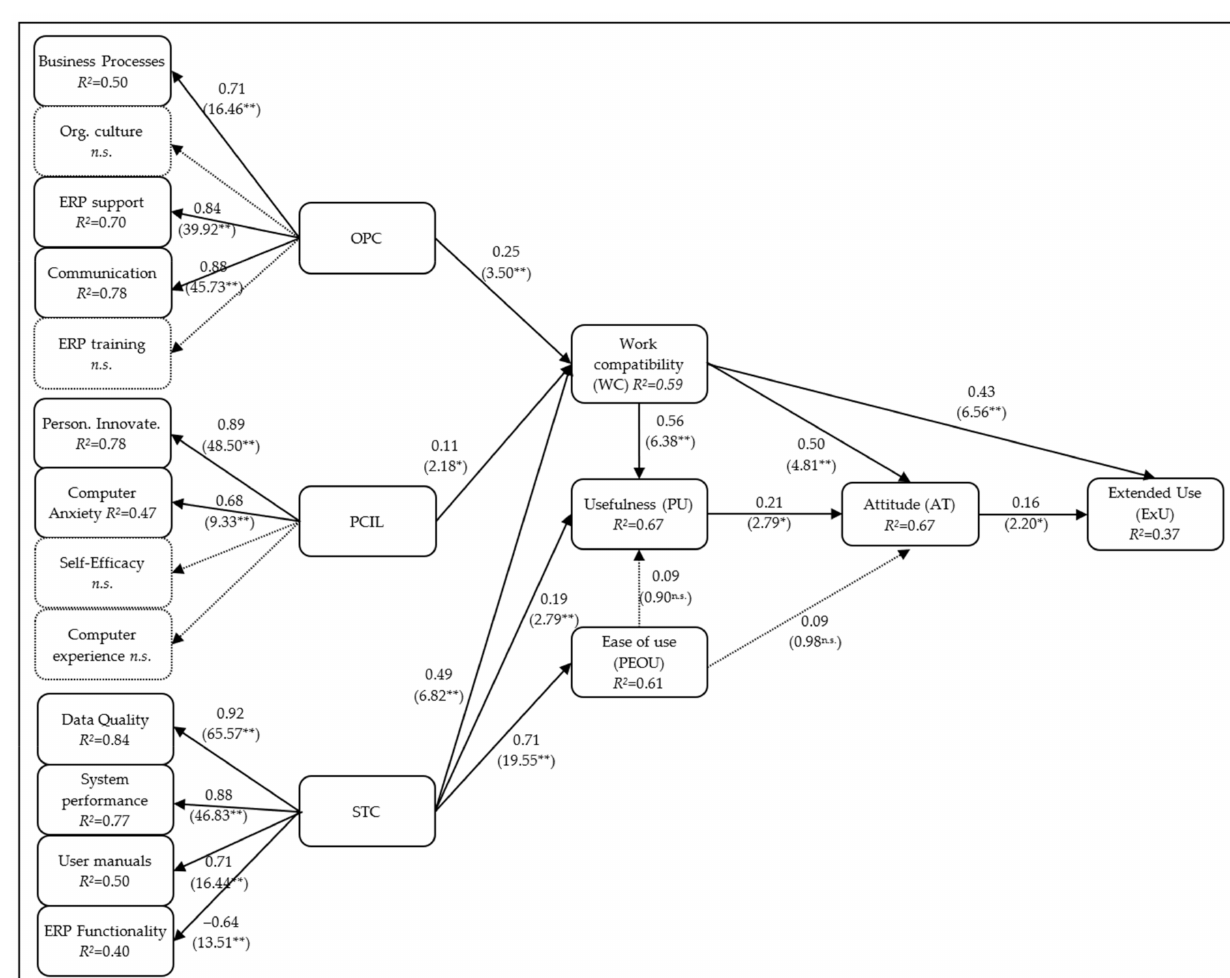
Figure 4. Findings of structural model analysis. Note: Path sign.: ** p < 0.01; * p < 0.05; n.s. = not significant (dotted